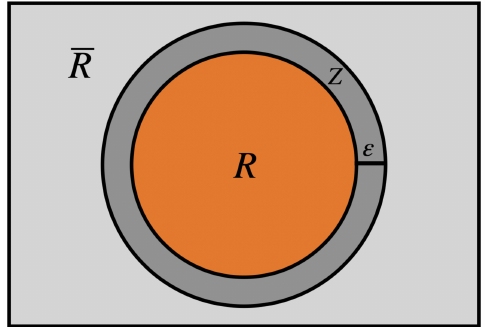
Figure 1 . Geometric configuration characterizing the definition of a twist operator τ g ( R, Z ) . The topology of the region R is not required to be trivial for the twist to be defined. The twist is constructed so as to effect the symmetry transformation in A ( R ) and leave the operators in A ( ¯ R ) invariant. The buffer zone Z with non-zero size (cid:15) is required for the operator to exist in the